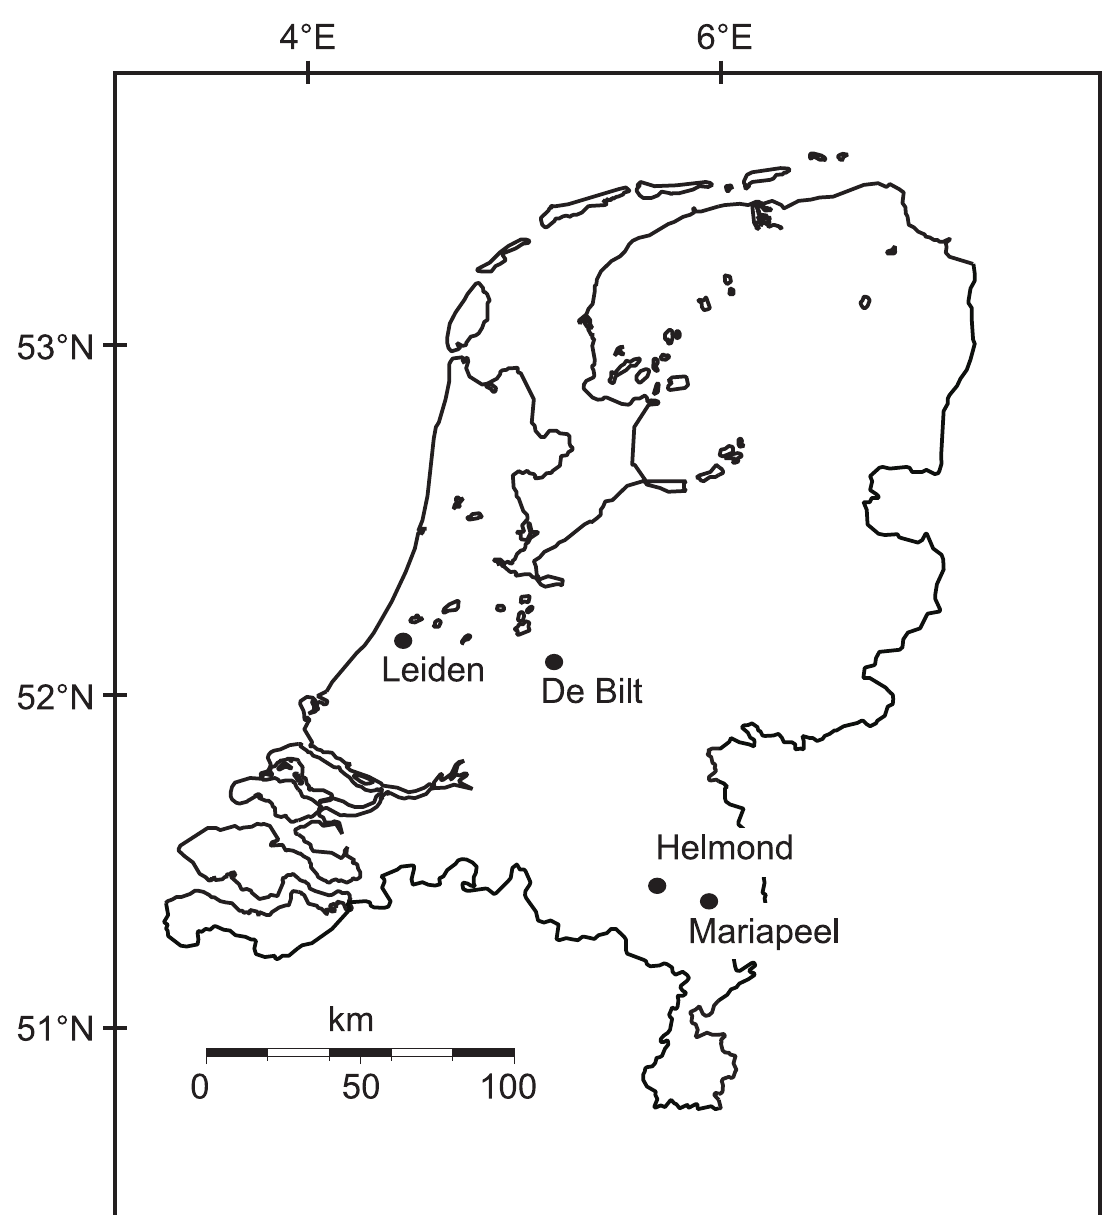
Figure 1. Map of the Netherlands showing the location of the LUMC (Leiden) and Elkerliek (Helmond) pollen traps, De Bilt meteorological station, and the peat deposit from Mariapeel Natural